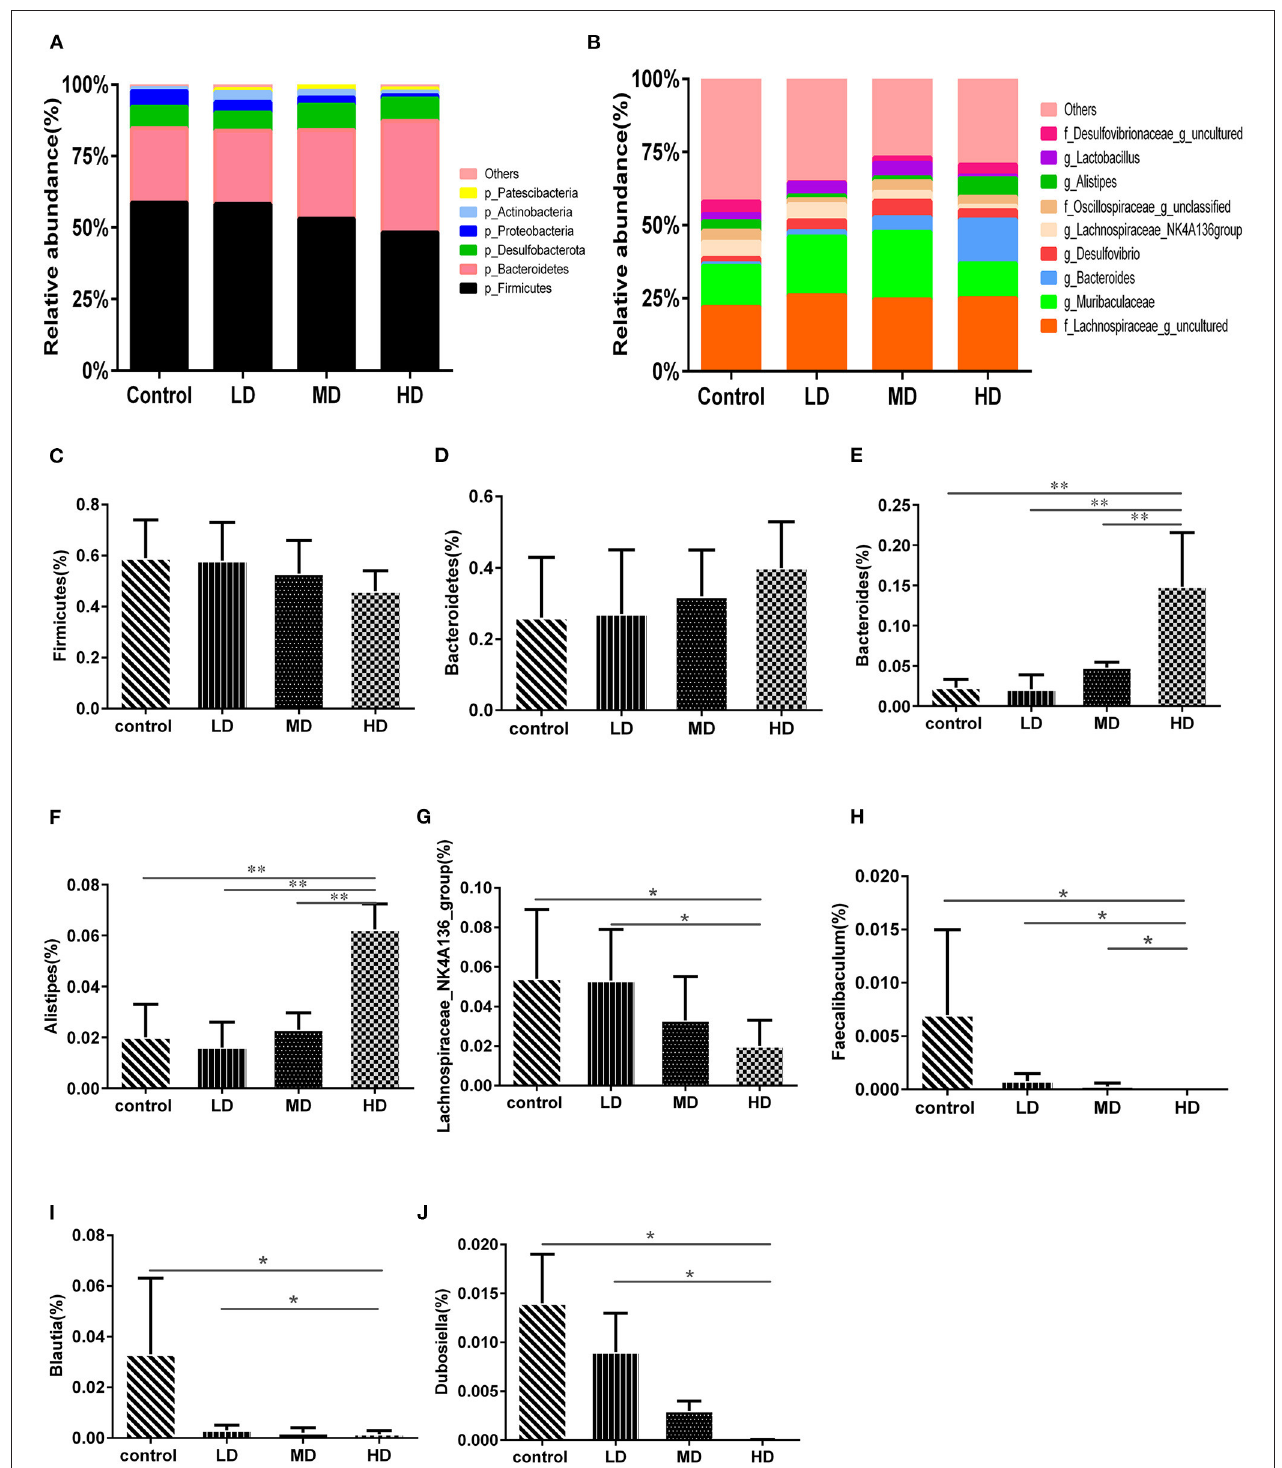
FIGURE 2 | High red meat intake alters gut microbiota. (A) The phylum level of microbiota composition and comparison of microbiota in mice fed with different levels of red meat diets: (C) Firmicutes, (D) Bacteroidetes. (B) The genus level of composition and comparison of microbiota in mice fed with different levels of red meat diets: (E) Bacteroides , (F) Alistipes, (G) Lachnospiraceae_NK4A136_group, (H) Faecalibaculum, (I) Blautia, (J) Dubosiella . The chart data are presented as mean ± SD, and * p < 0.05, ** p < 0.01. LD, low-dose red meat group; MD, medium-dose red meat group; HD, high-dose red meat group.